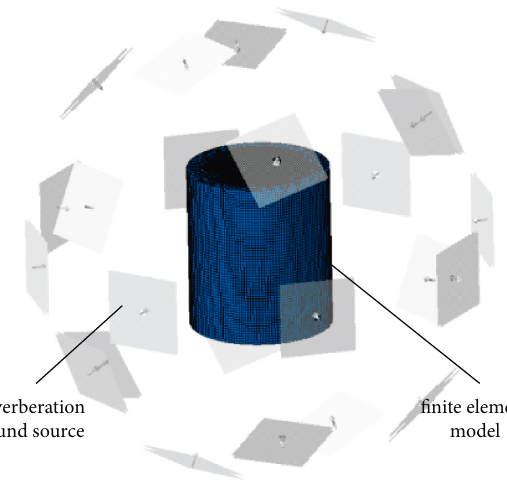
Figure 3: Boundary conditions of the finite element model.